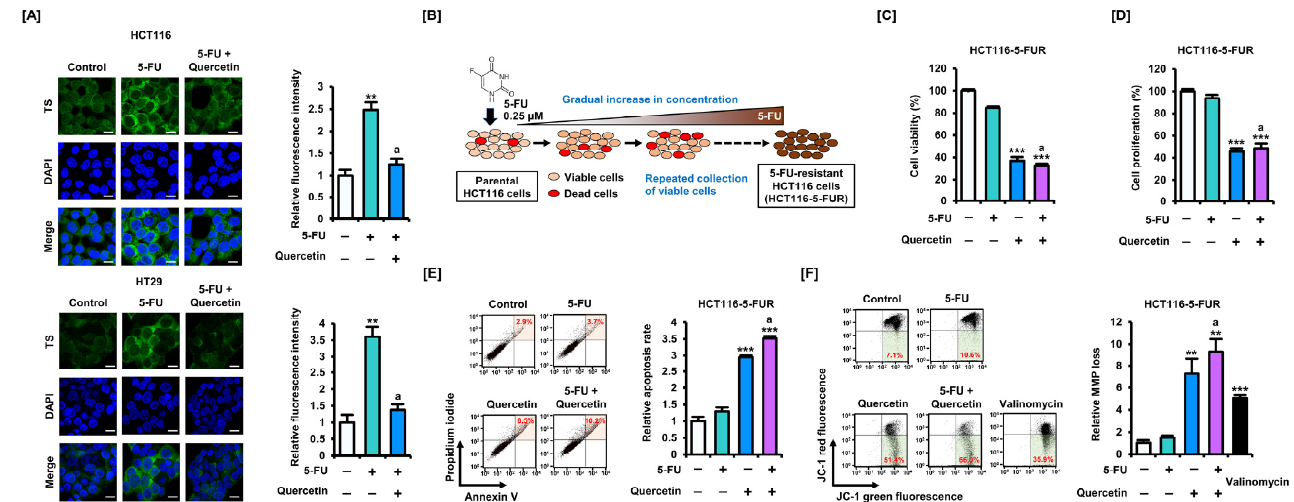
Figure 3. Effect of quercetin on alleviating 5-FU resistance in CRC cells. ( A ) Regulation of TS expres- sion by treatment with 5-FU (20 μ M) and quercetin (40 μ M), as analyzed by immunofluorescence (green) over 24 h. Nuclei were counterstained with DAPI (blue). The green fluorescence value meas- ured with MetaMorph software was divided by the blue fluorescence value to quantify fluorescence intensity. The scale bars represent 40 μ m. ( B ) Schematic diagram of the establishment of HCT116 cells resistant to 5-FU (HCT116-5-FUR). ( C ) Effects of 5-FU (20 μ M) and quercetin (40 μ M) combi- nation treatment on cell viability in HCT116-5-FUR cells over 48 h. ( D ) Effects of 5-FU (20 μ M) and quercetin (40 μ M) combination treatment on proliferation of HCT116-5-FUR cells over 48 h. ( E ) Ef- fects of 5-FU (20 μ M) and quercetin (40 μ M) combination treatment on apoptosis of HCT116-5-FUR cells over 48 h. Annexin V and PI fluorescence values were estimated by flow cytometry. The per- centage of cells corresponding to the upper right of the quadrant was used to compare the relative number of apoptotic cells. ( F ) Effects of 5-FU (20 μ M) and quercetin (40 μ M) combination treatment on mitochondrial membrane potential (MMP) loss in HCT116-5-FUR cells over 48 h. JC-1 fluores- cence values were estimated by flow cytometry. The percentage of cells corresponding to the lower right was used for relative comparisons. Asterisk indicates a statistically significant difference com- pared with untreated control cells (*** p < 0.001; ** p < 0.01). The symbol ‘a’ indicates a significant effect of combination treatment compared with treatment with 5-FU alone ( p < 0.05).